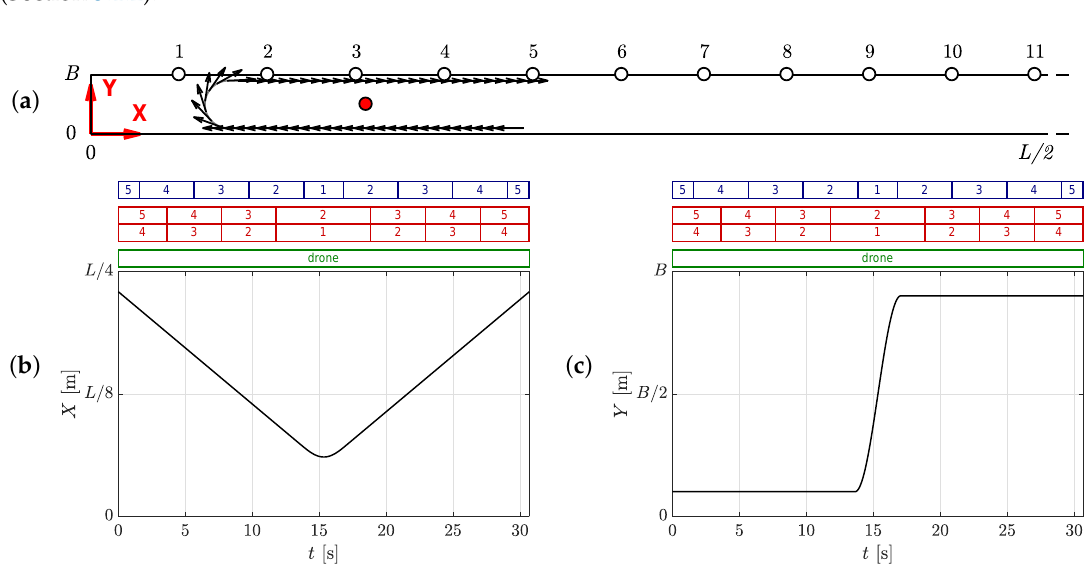
Figure 24. True trajectory of the theoretical example: ( a ) top view of the trajectory (line) and speed vector every 0.5 s (arrows) and indication of the position of the static cameras (white-filled dots) and drone (red-filled dot), ( b ) longitudinal and ( c ) lateral position over time with indication of the mono-vision static camera setup (blue), stereo vision static camera setup (red) and mono-vision drone camera setup